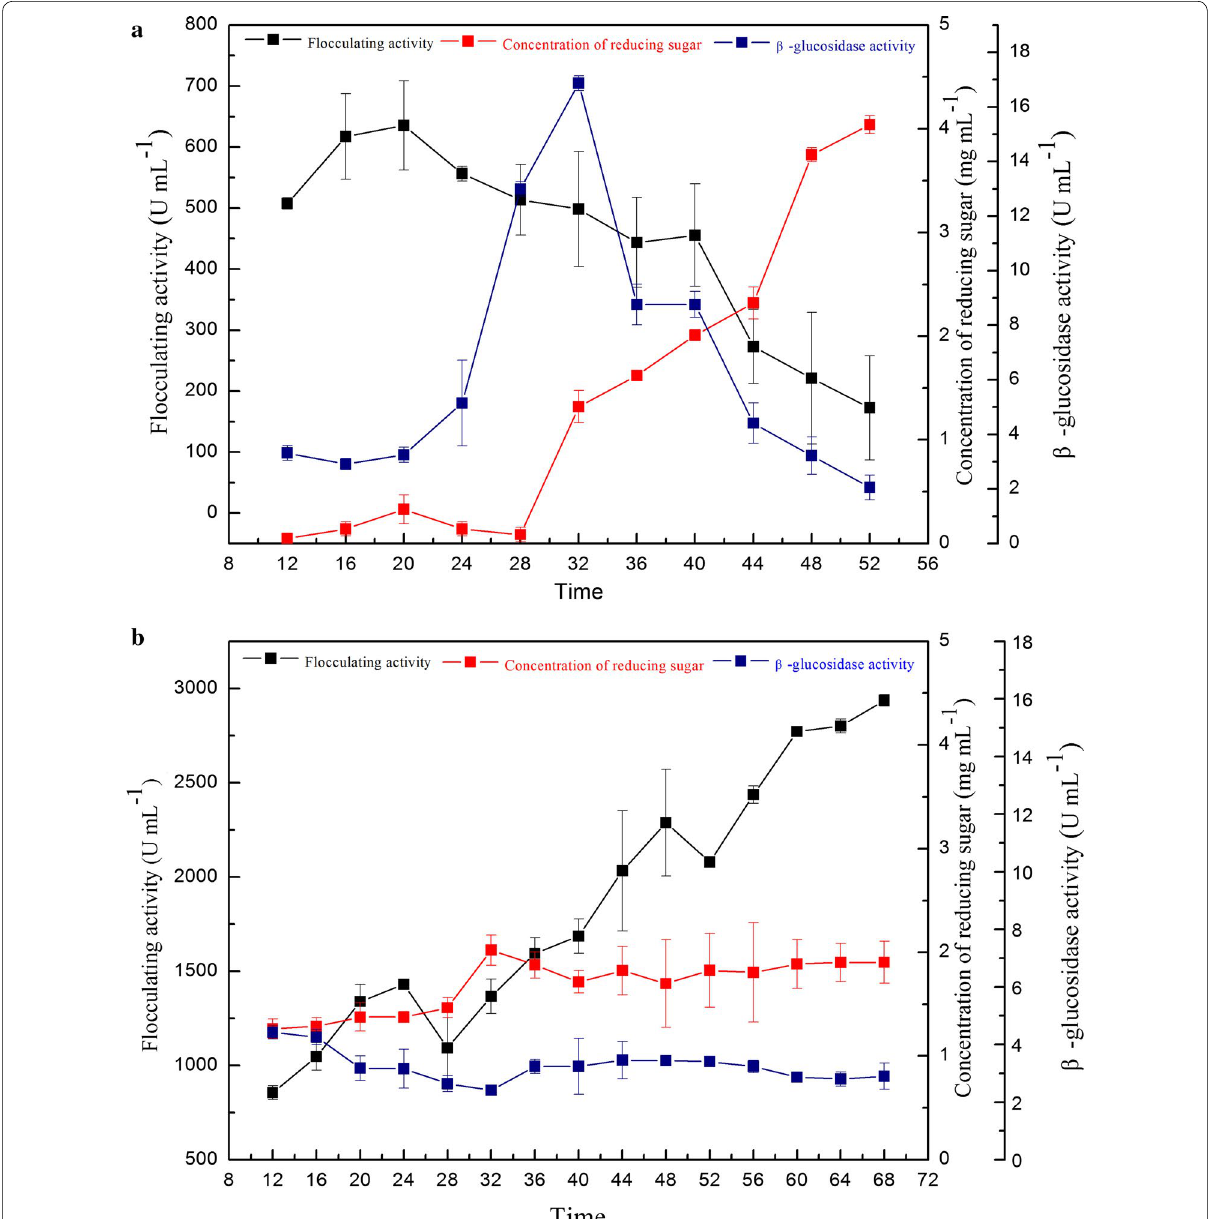
Fig. 1 Flocculating activity, β-glucosidase activity and the concentration of reducing sugars a using sucrose as substrate and b using glucose as